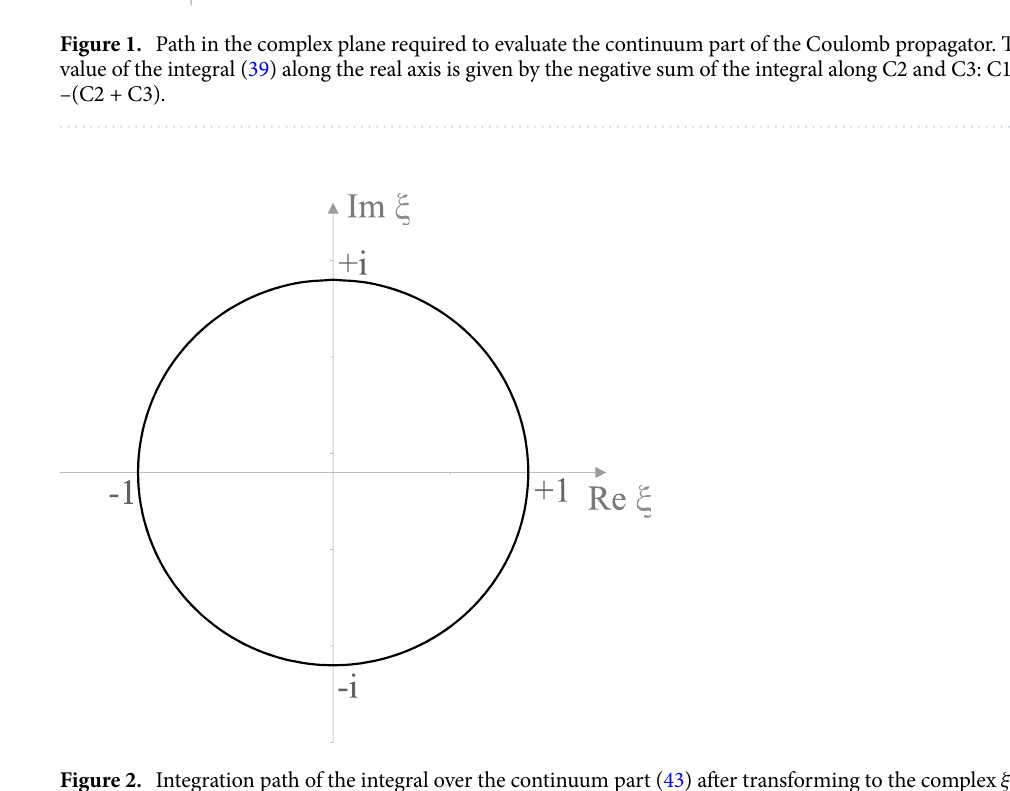
Figure 2. Integration path of the integral over the continuum part (43) after transforming to the complex ξ -plane. The integration path is a closed loop along the